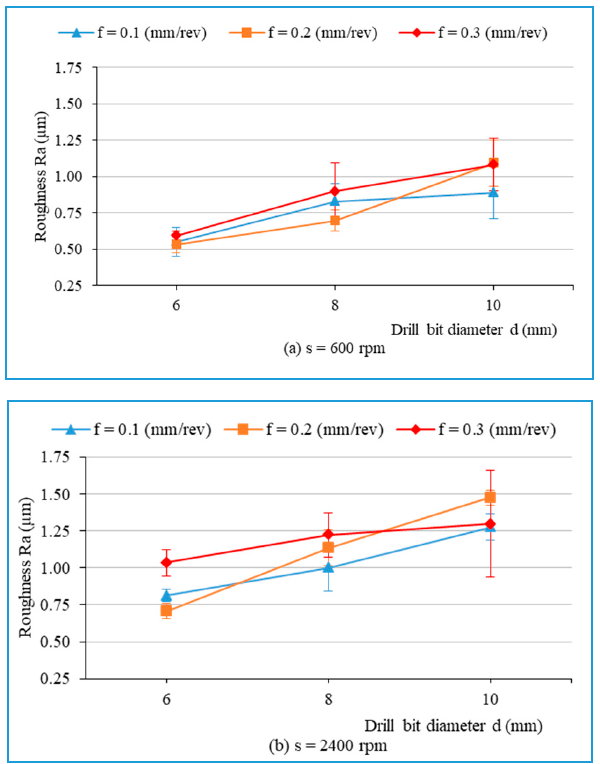
Figure 12. The roughness (R a ) versus drill’s diameter with di ff erent feed rates and spindle speeds: ( a ) s = 600 rpm, ( b ) s = 2400 rpm.